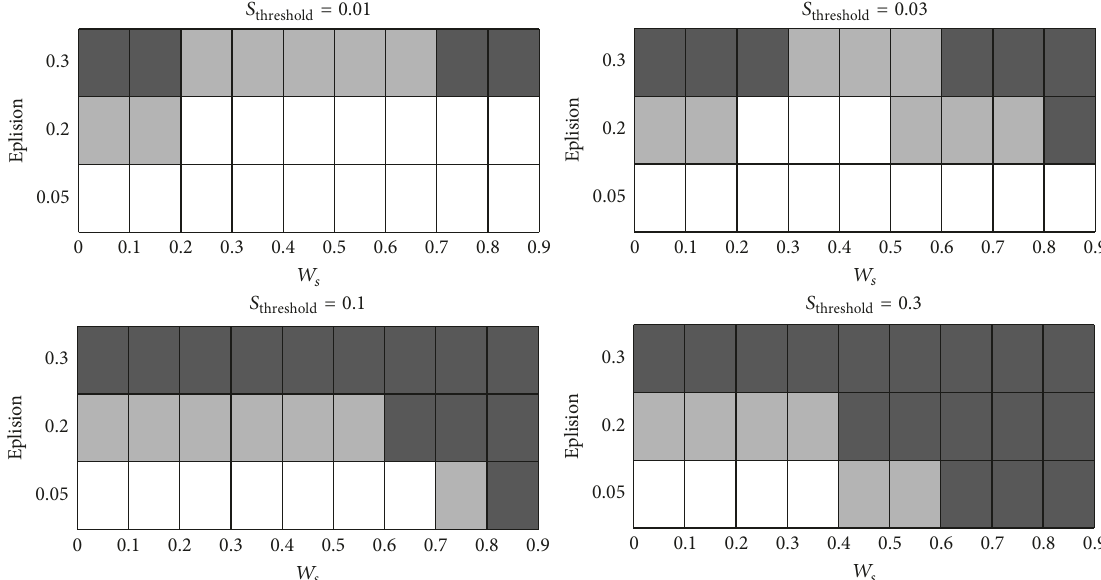
(𝑊 = 1) . 𝑠 threshold